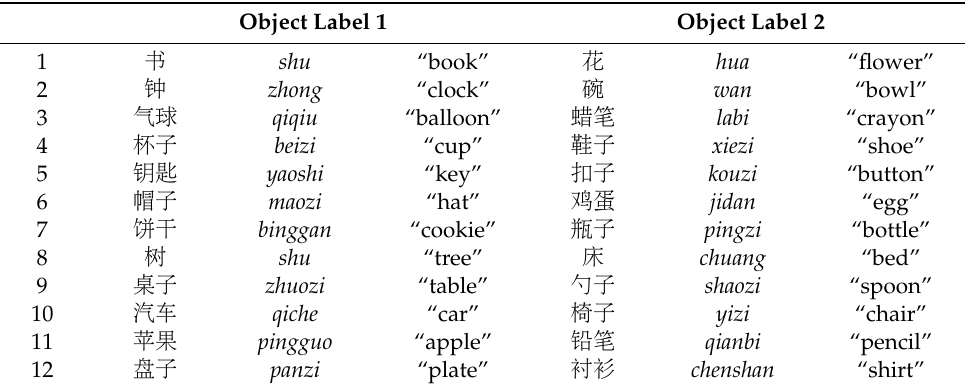
Table 1. Labels for target object pairs in